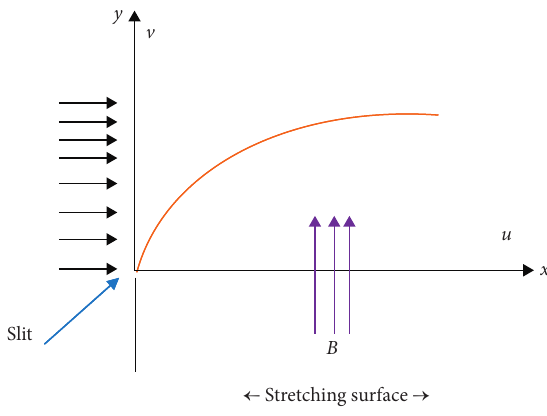
Figure 1: Geometry of the flow